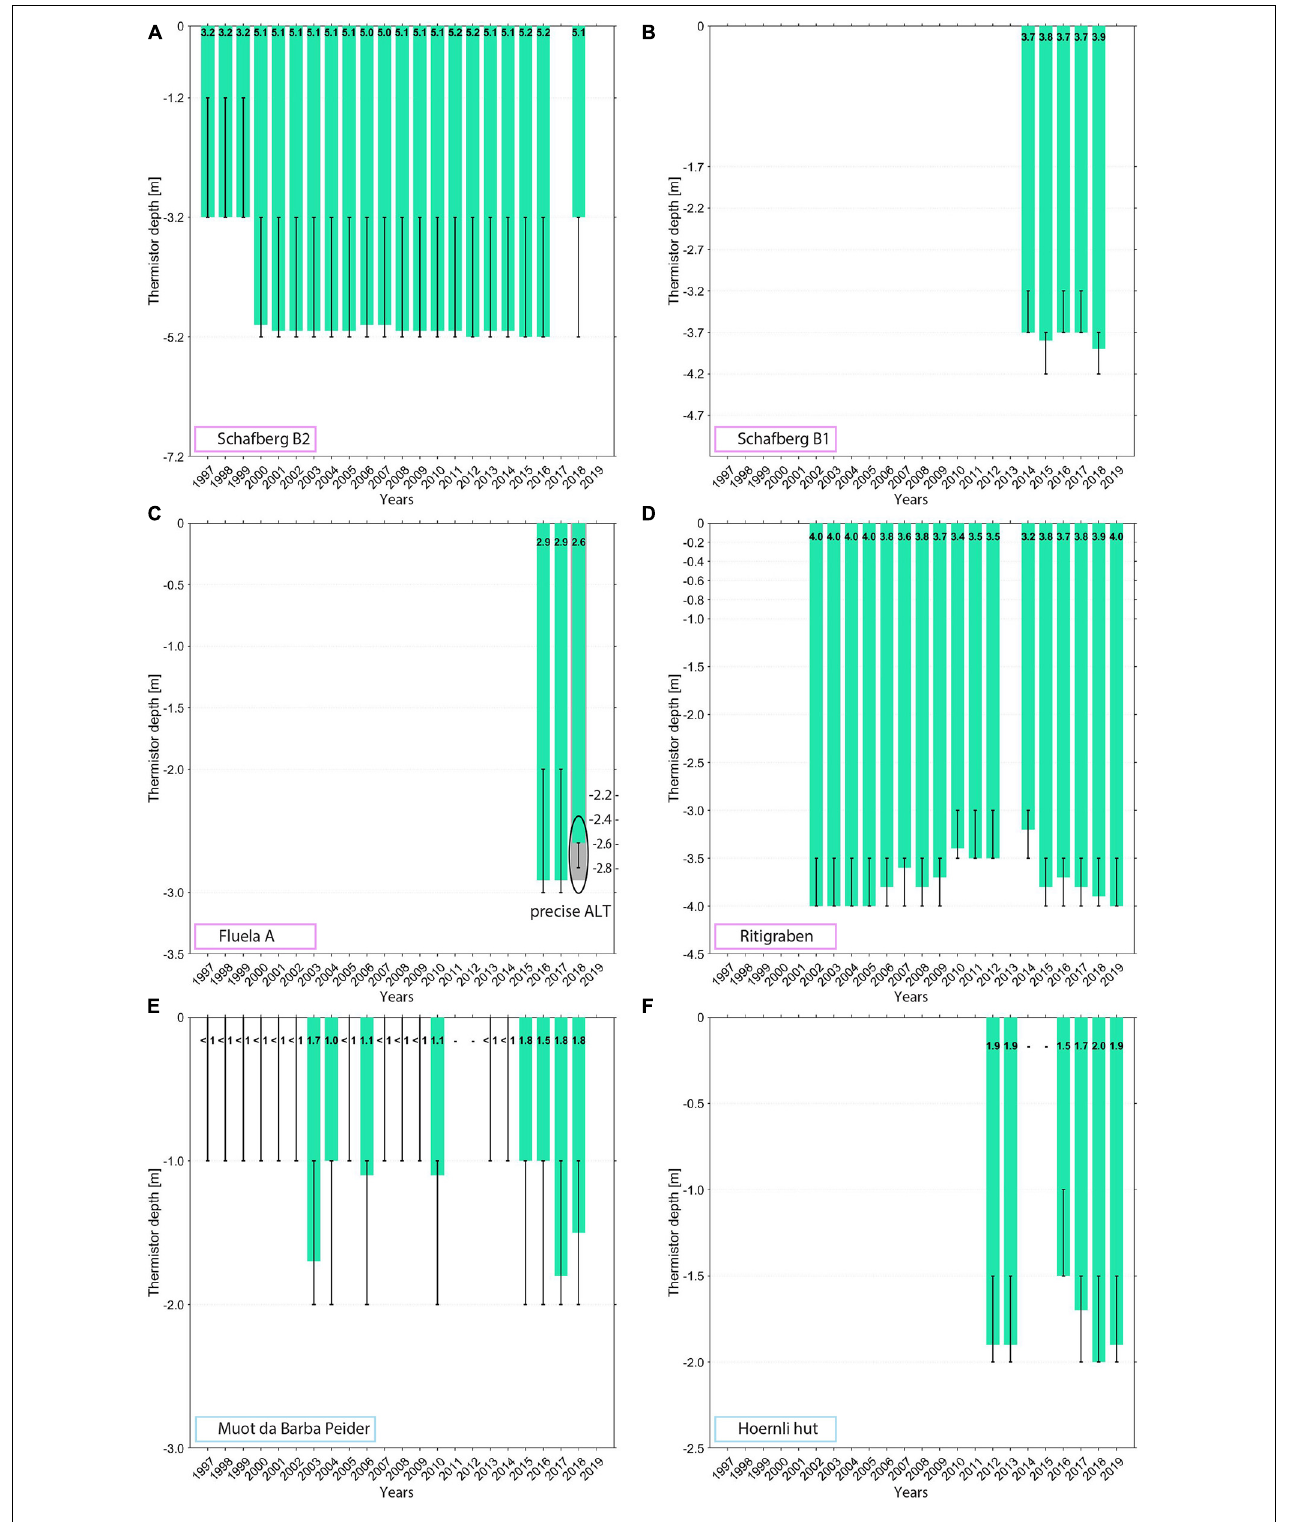
FIGURE 8 | Active layer thickness (green bars) for all boreholes located in permafrost. The thin black bars indicate the depths of the sensors used for linear interpolation (upper sensor in active layer, lower sensor in permafrost). (C) The grey bar below the green one indicates the advantage of more detailed active layer thickness calculation due to denser sensor spacing (black circle). The coloured frames indicate the ice content of the boreholes: (A–D) pink for ice-rich, and (E,F) light blue for ice-poor locations.